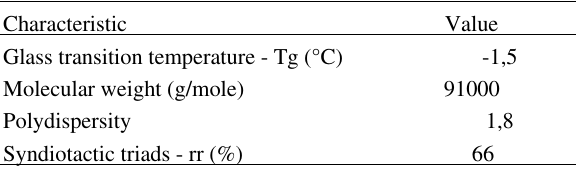
Table 1. Some characteristics of the ms-PP selected for blends prepara- tion.